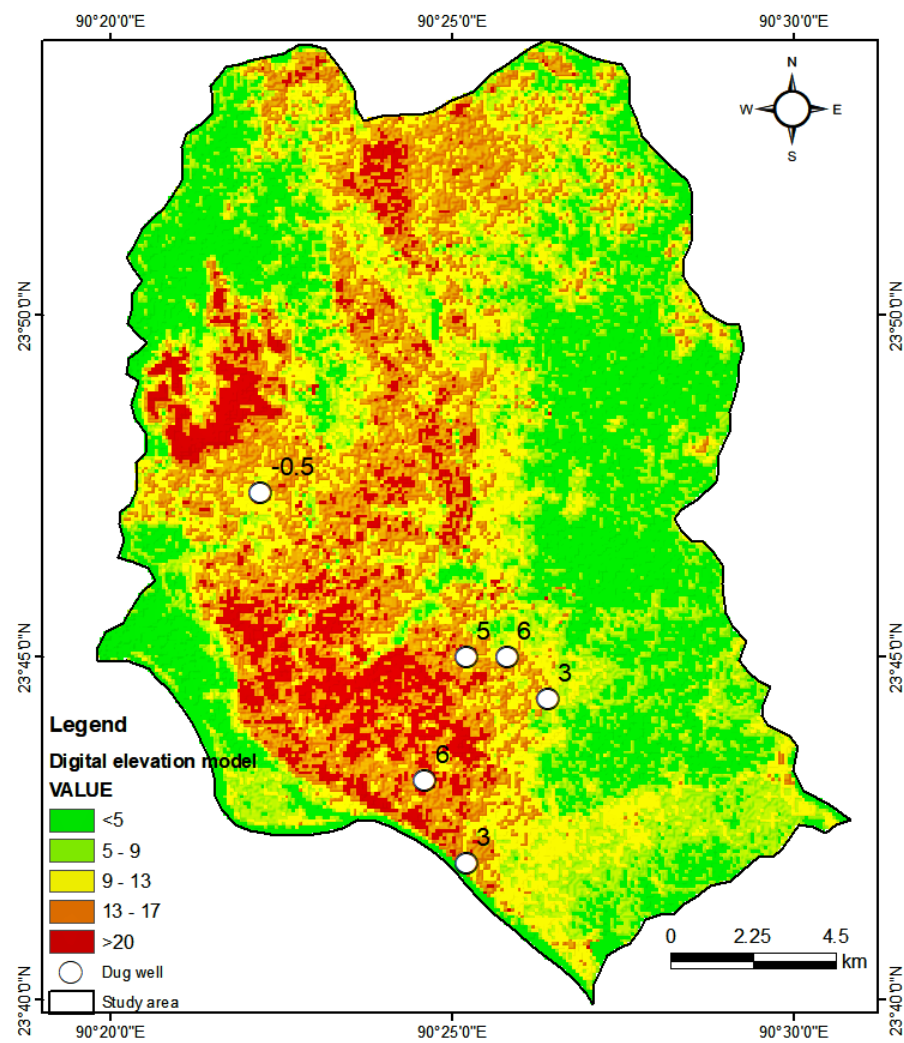
Figure 10. Spatial distribution of dug well water level (m PWD) of shallow aquifer on topographic map [81] for 1980.